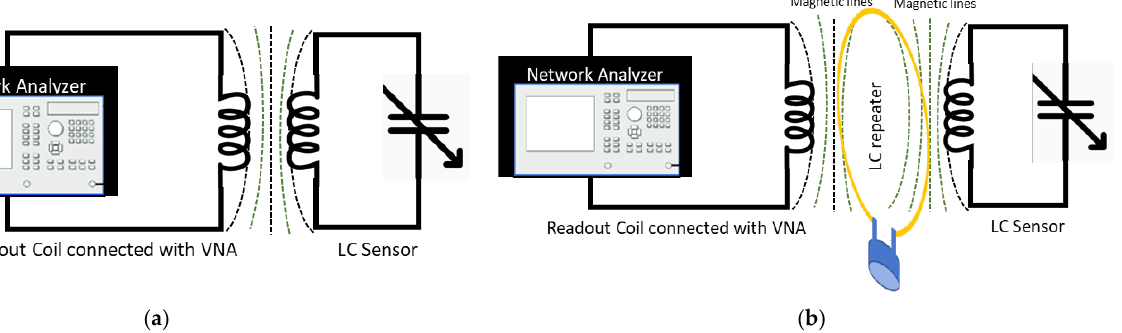
Figure 1. A Schematic of the LC sensing system with the readout coil connected with a VNA. ( a ) Sensing system diagram without a repeater coil. ( b ) System diagram with a repeater coil used to increase the measurement distance between the sensor and the readout coil.